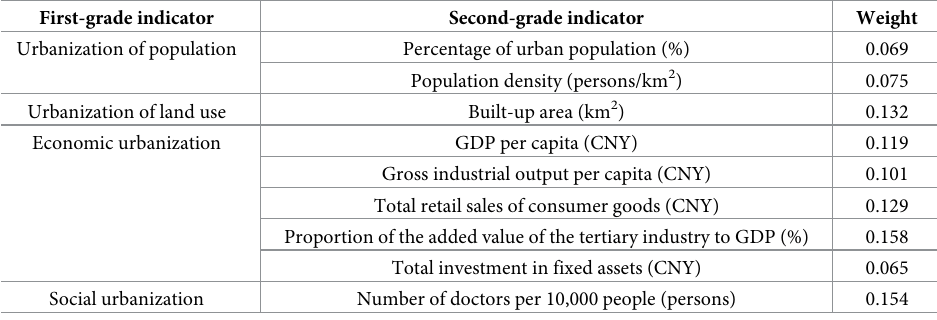
Table 1. Comprehensive evaluation indicators of urbanization